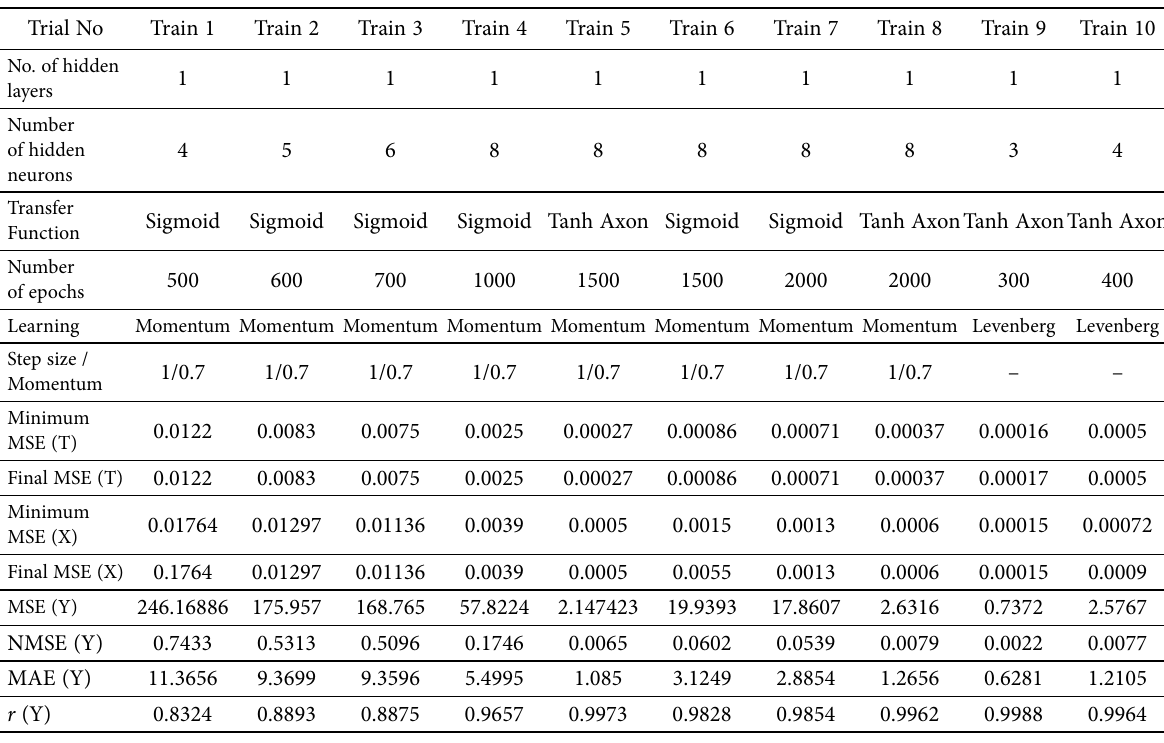
Table 5. Details of networks with different